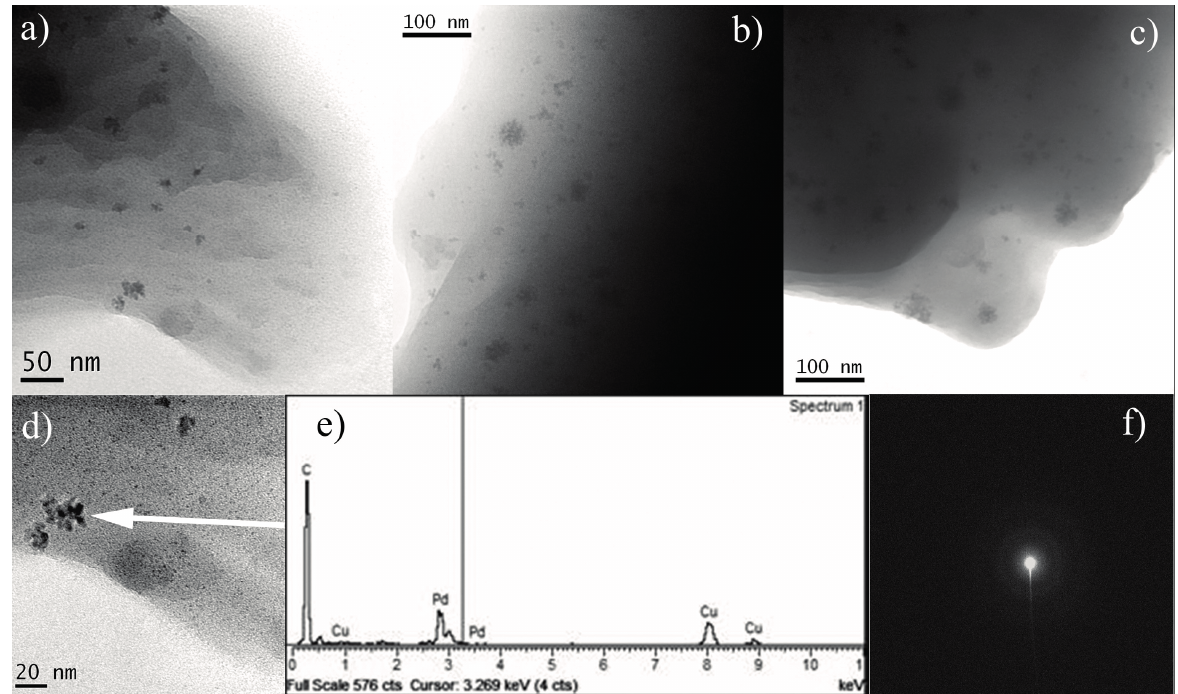
Figure 2. ( a – c ) TEM bright field images of three different batches of the pristine catalyst slice with PdNPs; ( d ) enlargement of a selected area of ( a ) accompanied by the corresponding ( e ) EDS spectrum and ( f ) SAED pattern.